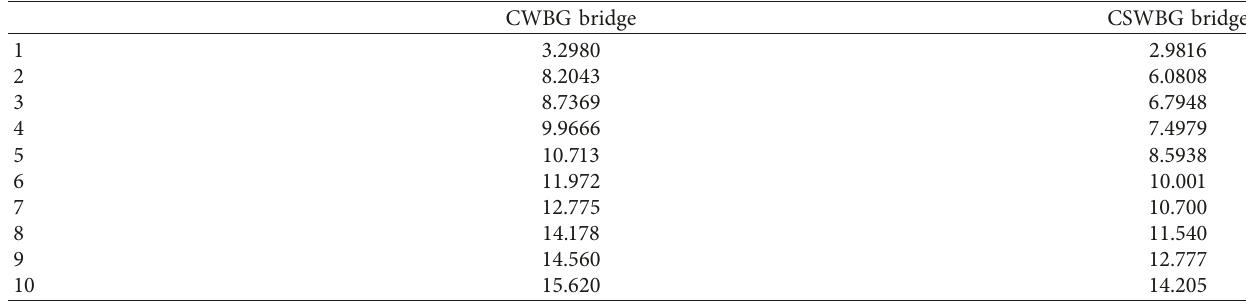
Table 2: Comparison of the first 10 natural frequencies of the two models. CWBG bridge CSWBG